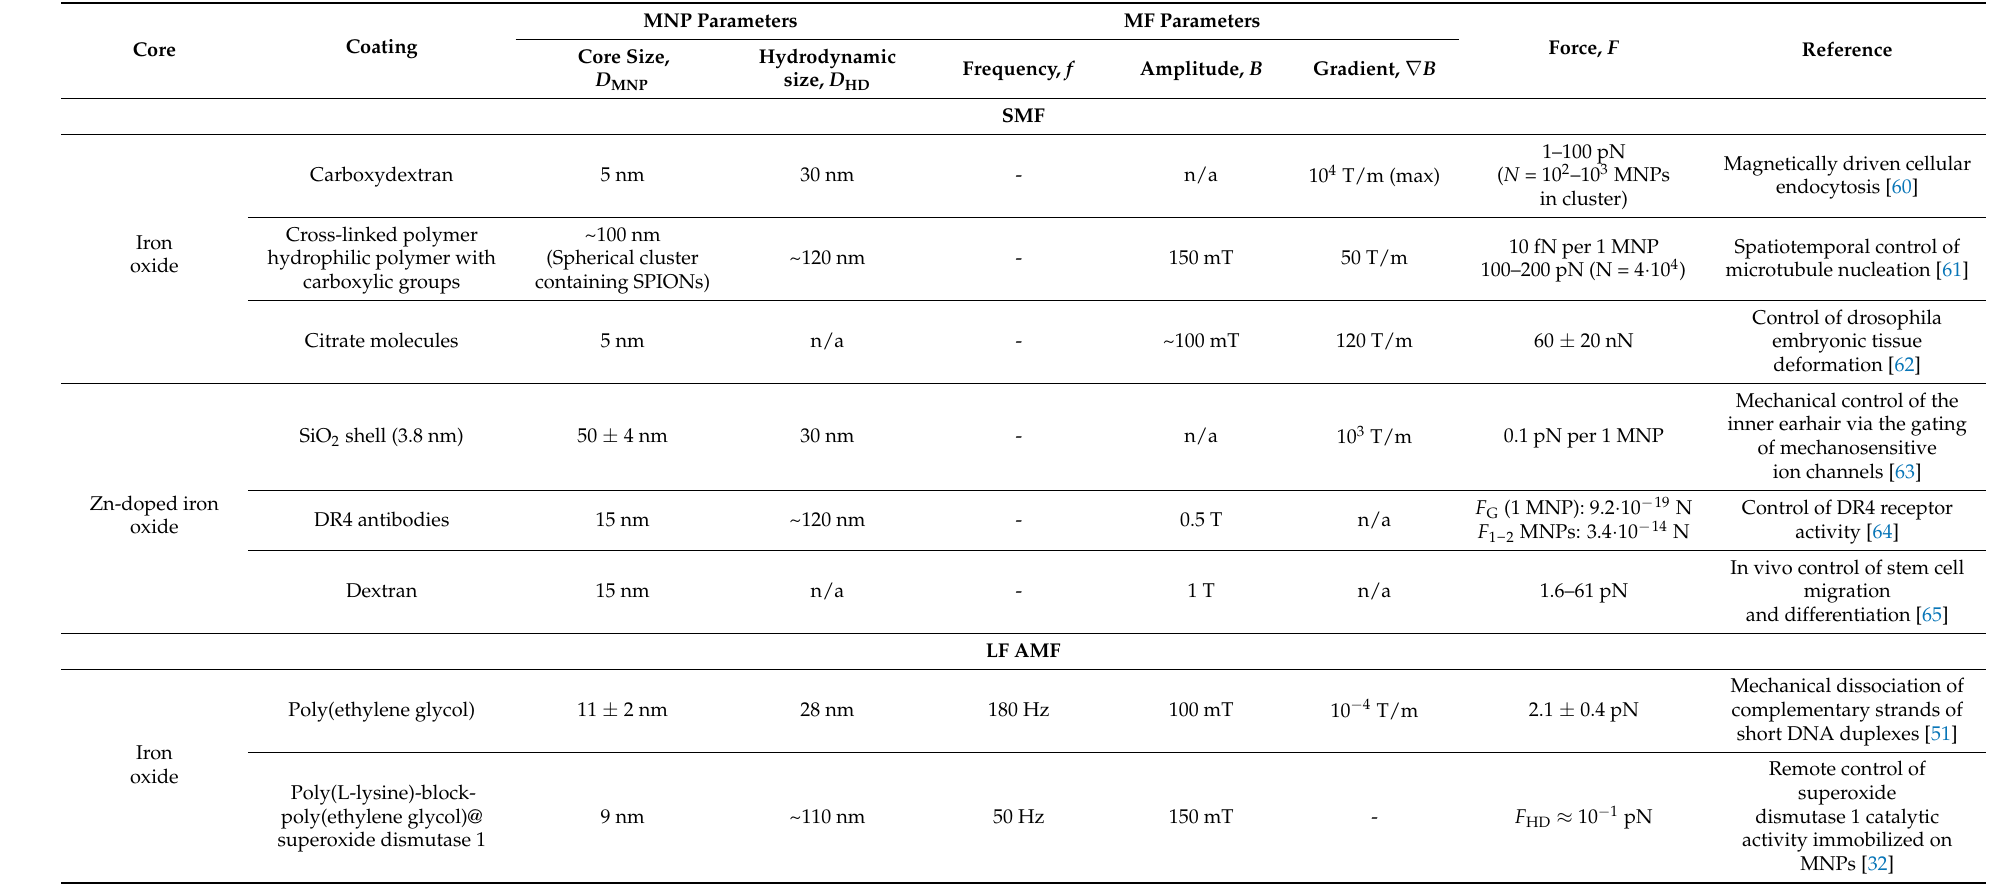
Table 1. MNP-mediated magneto-mechanical effects in various